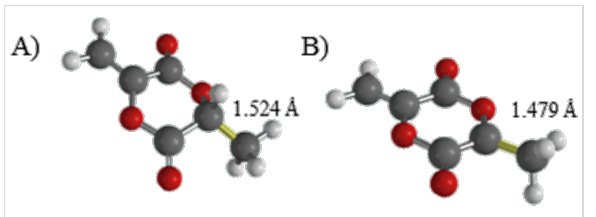
Figure 3: DFT-calculated C–C binding length (yellow) of (A) MLA and (B) the corresponding radical.